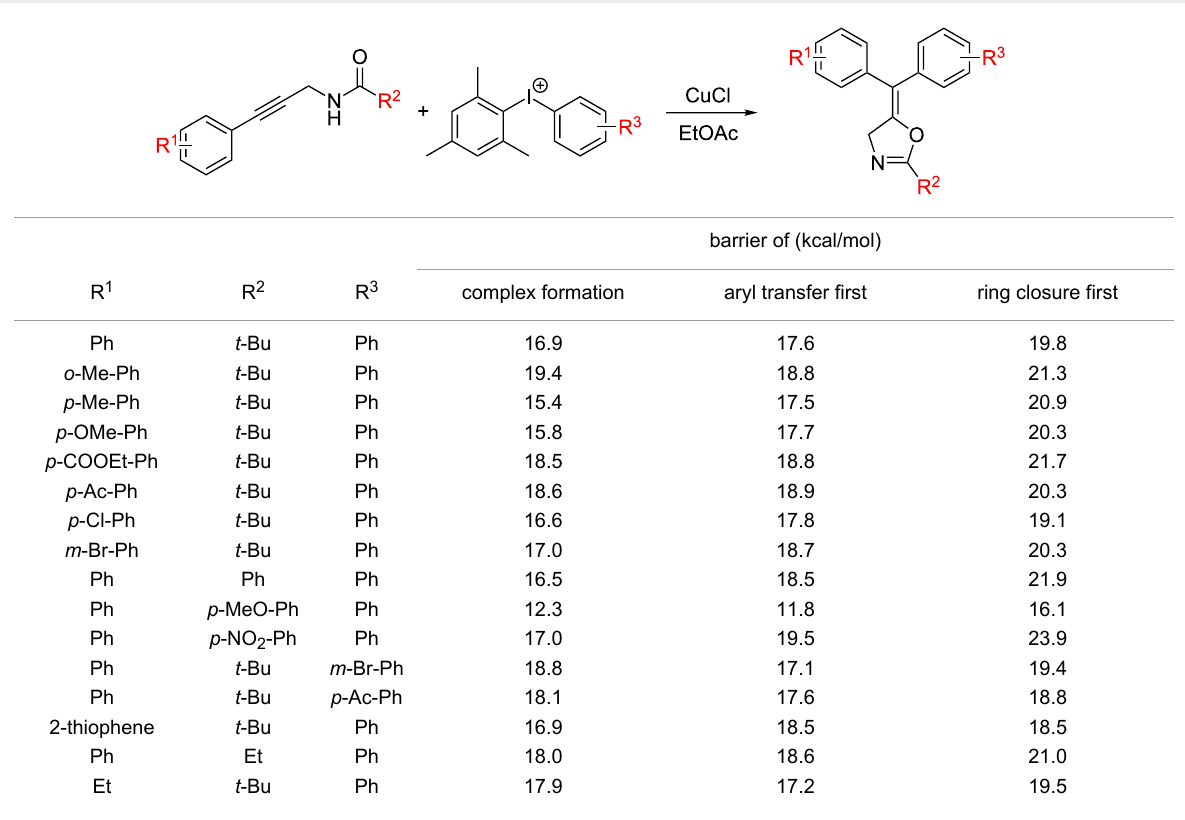
Table 1: Effect of the substituents on the barrier heights (kcal/mol). Selection of the substituents is based on